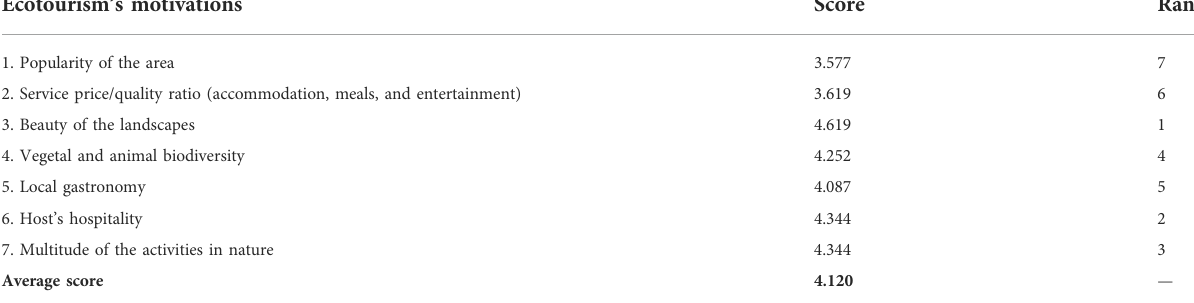
TABLE 4 Scores re fl ecting the most important motivations of the young tourists to choose an ecotourism destination. Ecotourism ’ s